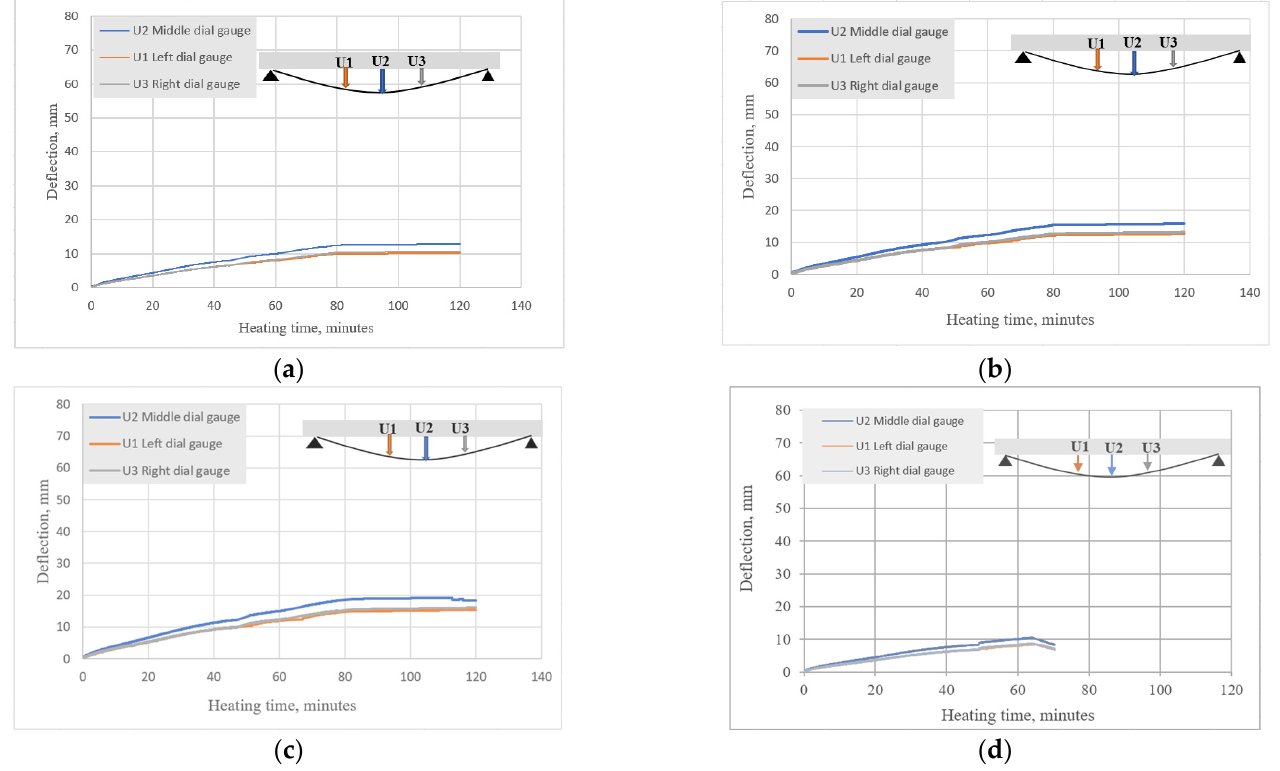
Figure 10. Heating times vs. deflections measured by three dial gauges for set 1.2: ( a ) H2Ø14-sample 1; ( b ) H2Ø14-sample 2; ( c ) H2Ø14-sample 3; ( d ) set 1-prev: